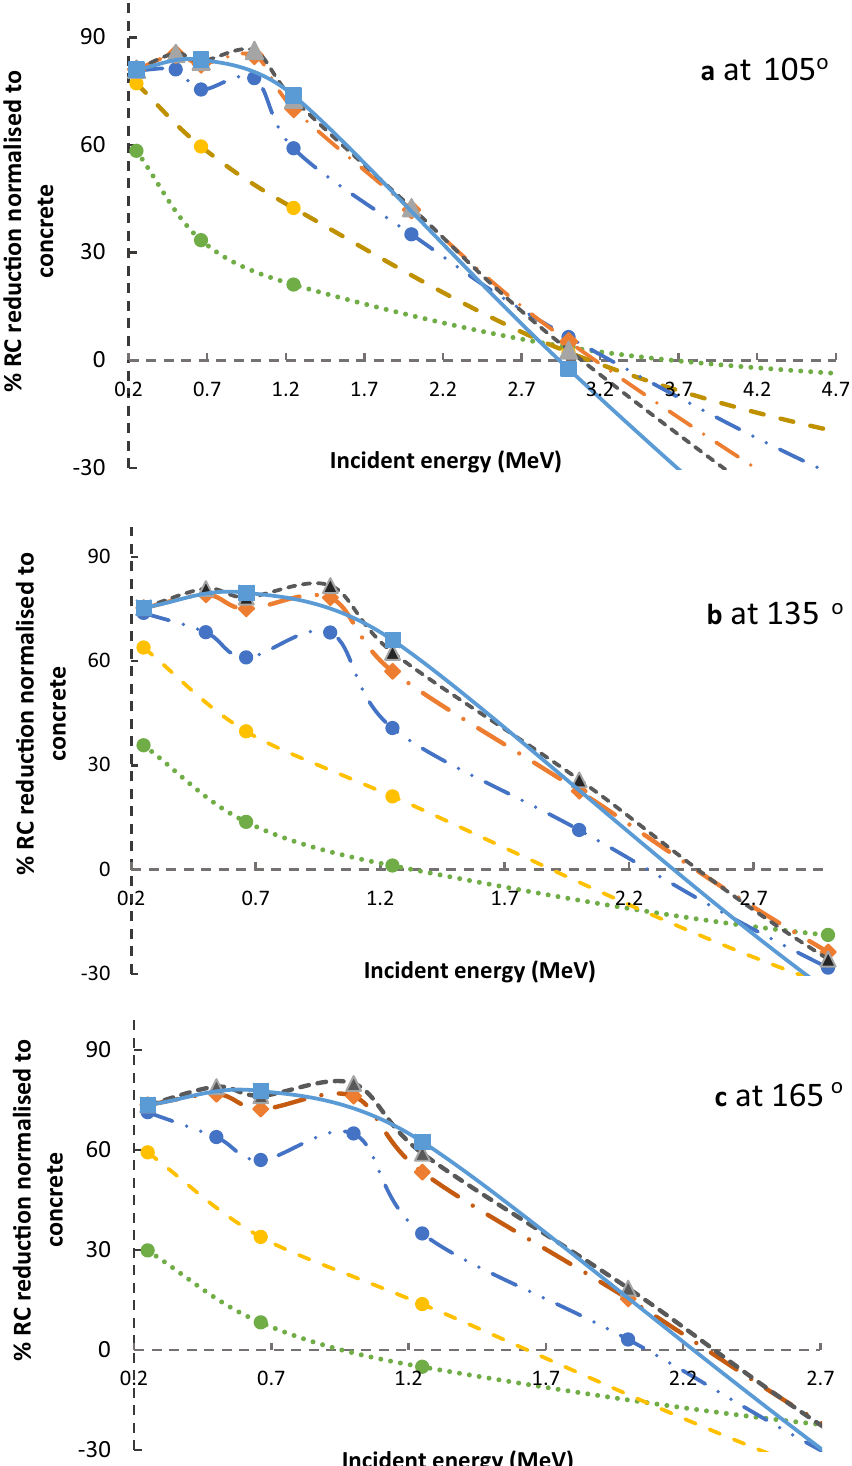
Figure 7. The percentage reduction factors of reflection coefficient (% RC) normalised to ordinary concrete for various thickness of lead covering the ordinary concrete as a function of incident photons energy. ( a ) at reflection angles of 105°, ( b ) at reflection angles of 135°, and ( c ) at reflection angles of 165°. represents 0.2 mm Pb, represents 0.5 mm Pb, represents 1 mm Pb, represents 2 mm Pb, represents 3 mm Pb, and represents 6 mm